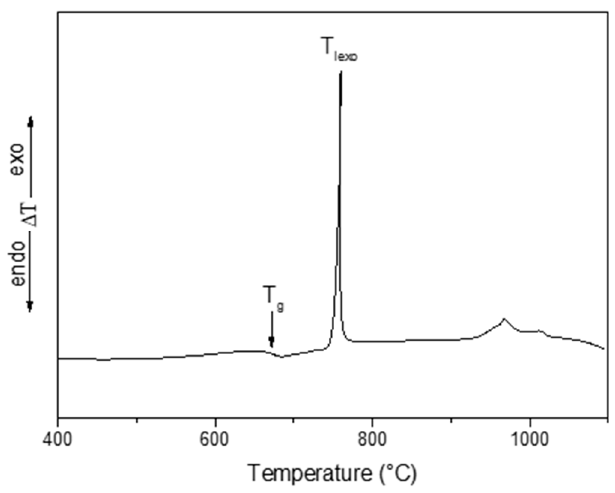
Figure 1. DTA curve of the bulk initial BaNaNS glass recorded in air at 10 K·min − 1 . It was shown that at the temperature of the first exothermic DTA peak ( T Iexo = 758 °C), crystallization of Ba 2 NaNb 5 O 15 occurs [46]. This phase belongs to the tetragonal tung- sten bronze (TTB) family, which is a set of non-centrosymmetric crystals showing good NLO properties [60]. TTB compounds have a general formula of (A1) 2 ·(A2) 4 ·(C1) 4 (B1) 2 ·(B2) 8 ·O 30 , where the five kinds of sites are available to be filled by different atoms. They allow the formation of many isomorphous crystals, showing NLO properties in a wide compositional range [61,62]. In our case, square A1 sites are occupied by Na, pen- tagonal A2 sites are occupied by Ba, and B1 and B2 octahedral sites are occupied by Nb, whereas the C sites are empty. It was shown that the Ba 2 NaNb 5 O 15 phase crystallizes due to a bulk nucleation mechanism [46]. As known, in glass, the maximum of nucleation rate occurs at T g ; therefore, to increase the number of crystalline nuclei, isothermal nucleation heat treatments were performed for different times, T g . Owing to high number of crystalline nuclei, the DTA crystallization peak of nucle- ated samples shifts towards lower temperatures. The largest shift (T Iexo nu. = 730 °C), which was observed for the 6h heat treatment, produces the highest number of nuclei. This down shift is a consequence of the formation of many crystalline nuclei uniformly dispersed in the glassy matrix. They facilitate the growth of a very high number Ba 2 NaNb 5 O 15 nano- crystals, preserving the full transparency of the sample [46]. Based on these data, TGCs were obtained by the following heating programs performed on samples that were heat treated 6 h at T g (nucleated samples). Program (1): heated at 10 K·min − 1 up to the temper- ature of the first DTA exothermic peak (T Iexo nu. = 730 °C); program (2): heated at 10 K·min − 1 up to the end temperature of the first DTA exothermic peak (T end nu. = 745 °C) and held at this temperature for 30 min; program (3) heated at 10 K·min − 1 up to the extrapolated onset temperature of the first DTA exothermic peak (T ext nu. = 700 °C). As later described, the analysis of the Raman spectra of samples subjected to the above thermal programs evidence that program (3) gives rise to an intermediate stage between the initial glass and the fully nanostructured samples. This indicates that at this stage, the nanocrystallization process is not yet complete, whereas its completion takes place only after the programs 1 and 2, where the highest Raman gain values were ob- tained. Consequently, in the following part, we focus our attention only on the glass sub- jected to heating programs (1) and (2). In Figure 2, XRD patterns of the initial BaNaNS glass and of nucleated BaNaNS glasses subjected to program (1) and to program (2) are shown. The initial glass is